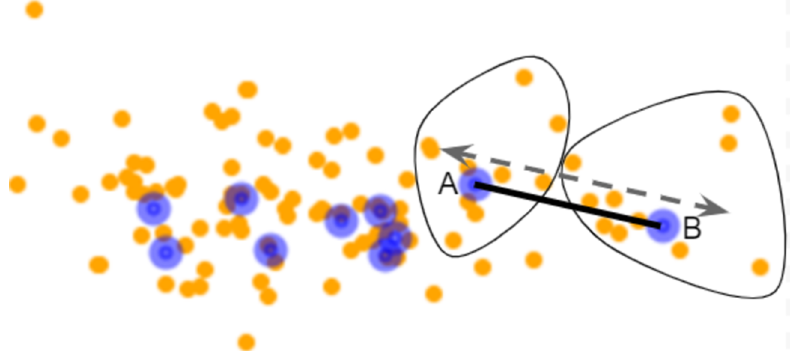
Figure 16. Visualizing in 2-D the accuracy of representing a larger, higher-resolution sample (yellow dots, used to construct G hr ) by a smaller, weighted sample (blue circles, used to construct G lr ). Blue nodes A and B have circled around them approximately the 10 closest yellow nodes that would be assigned to them uniquely. The linking length (grey dotted line) is long enough to connect A and B, and long enough to connect any two points assigned to the same blue node, ensuring full internal connectivity. However, some of the yellow nodes assigned to A will not be linked to some of those assigned to B, therefore the assumption of identical external connectivity does not